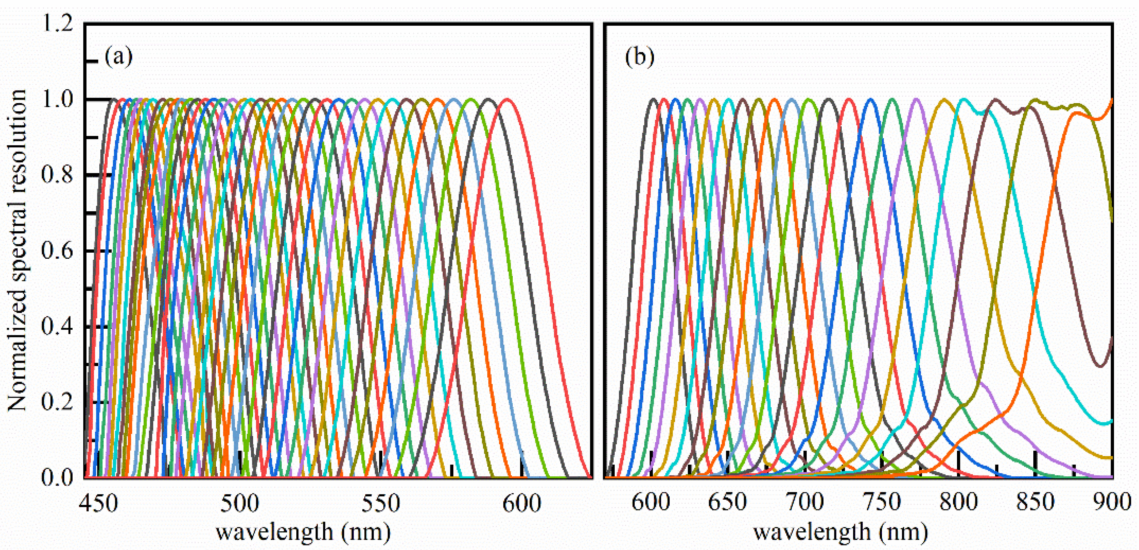
Figure 7. Spectral resolution test results of the hyperspectral imager. ( a ) For spectral channels 1–38 and ( b ) for spectral channels